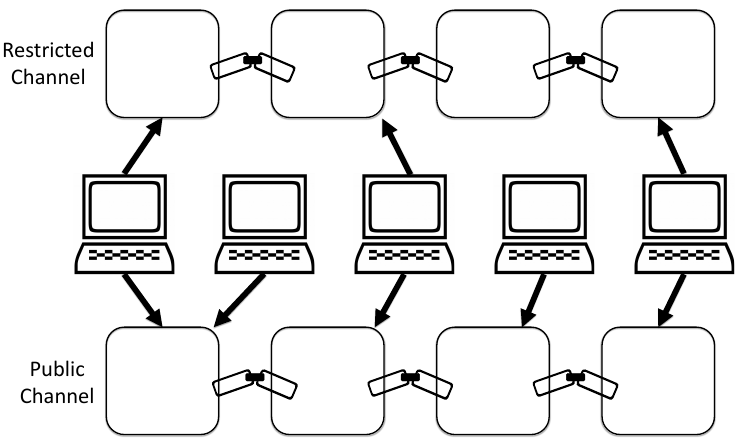
Figure 5. Separate channels with distinct blockchains. Here we demonstrate a set of peer nodes (who are also participants in this figure), all of whom have access to the public channel ( bottom ), yet with only some of the peer nodes having access to the restricted channel ( top